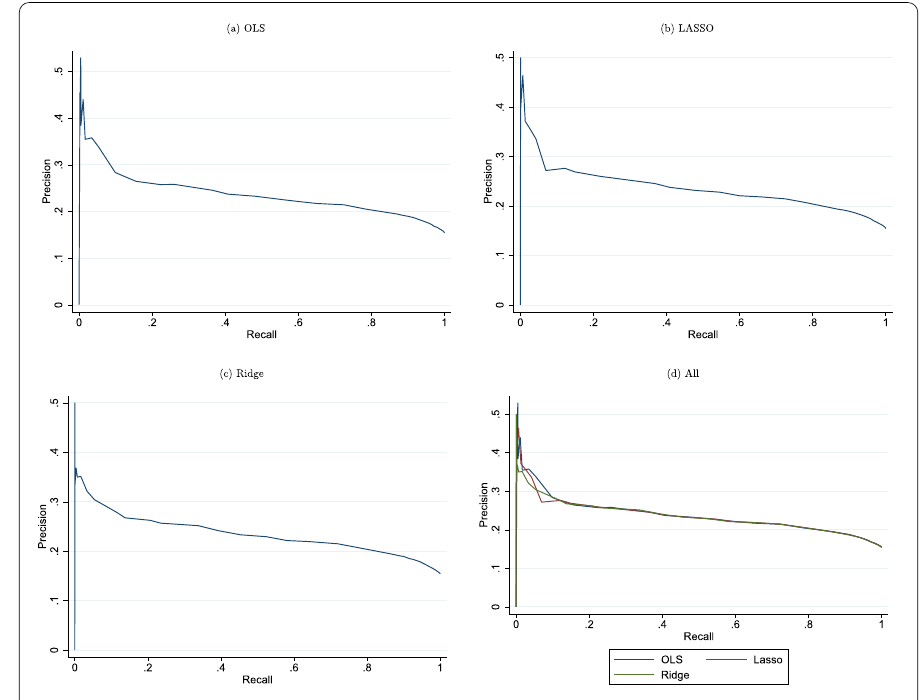
Figure A.1 Precision and recall curves. Small model—main data